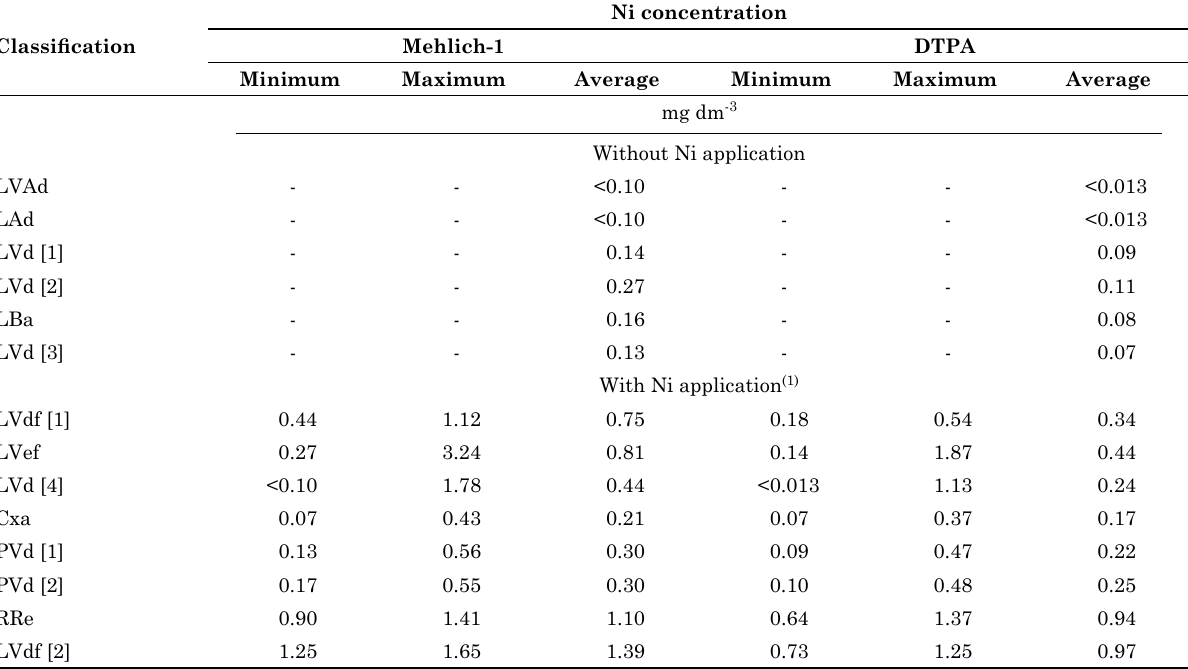
Table 3. Available levels of Ni extracted by DTPA and Mehlich-1 in 14 soil samples collected from the 0-20 cm layer